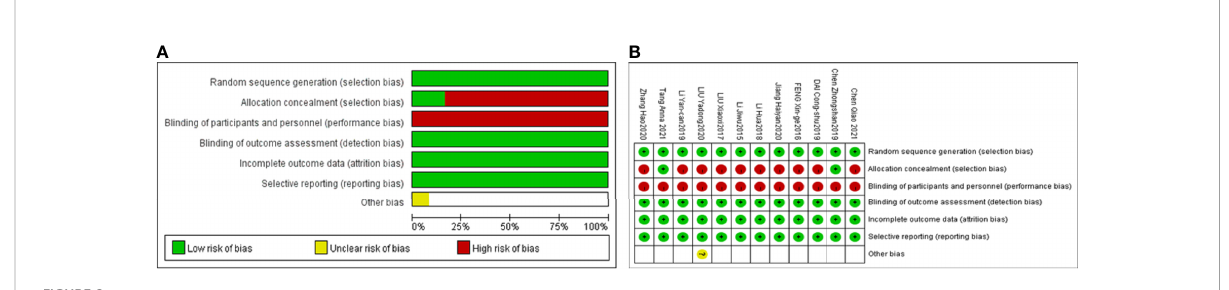
FIGURE 2 Risk of bias graph (A) , risk of bias summary (B) .